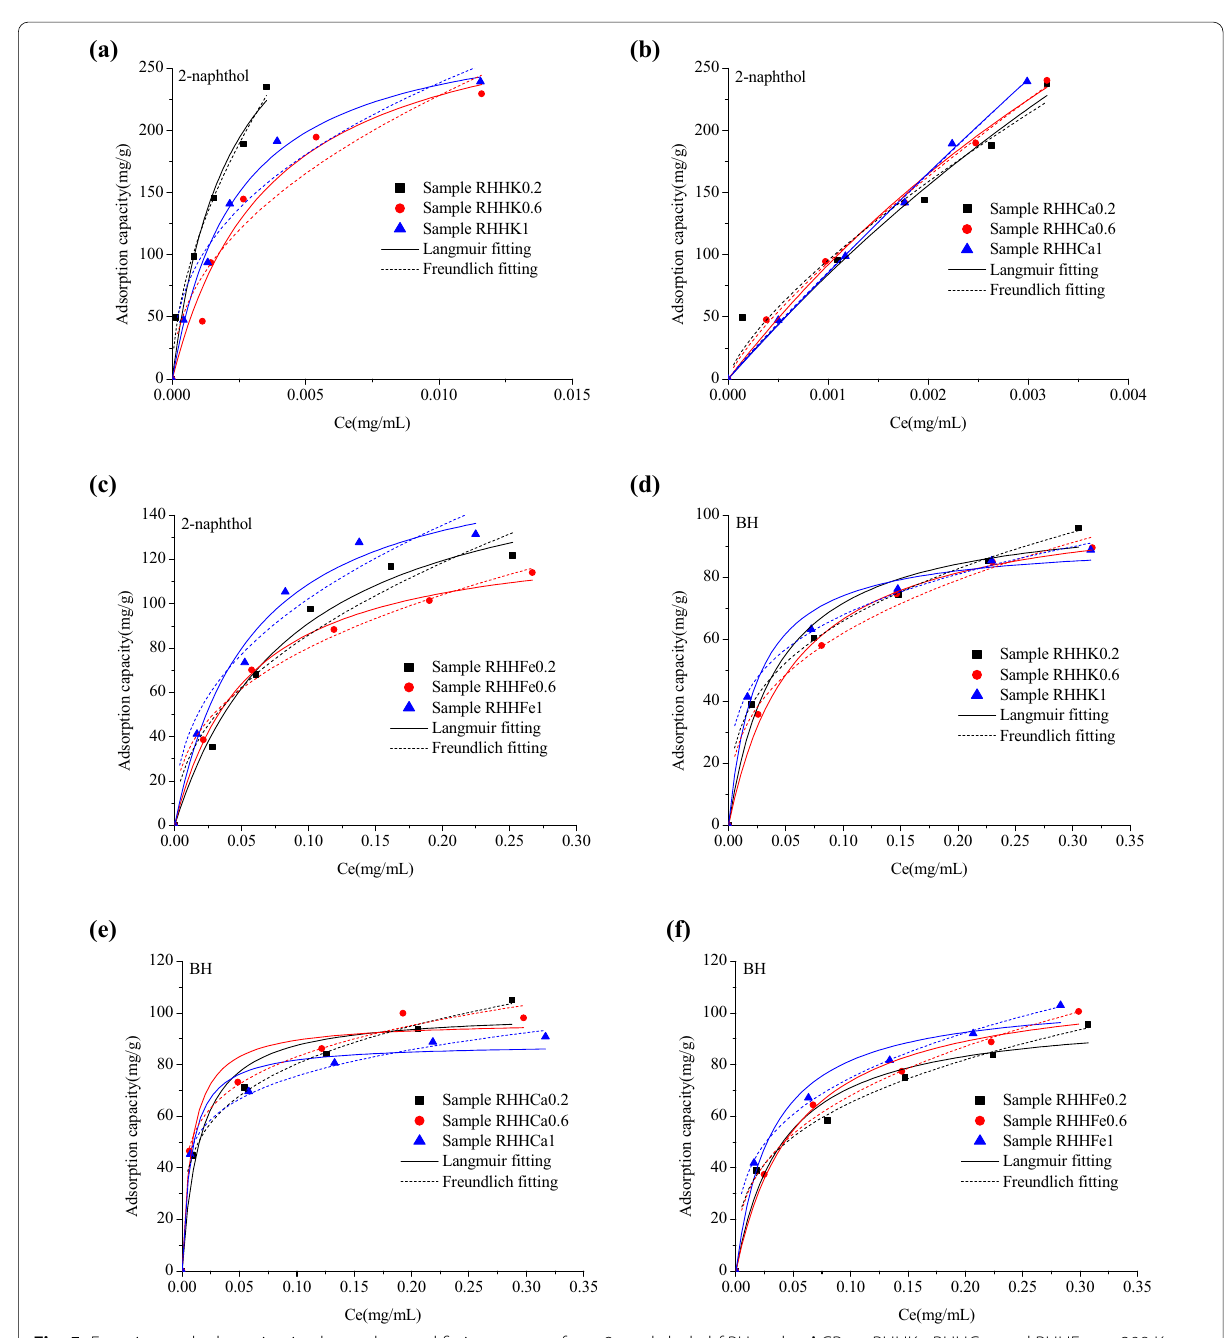
Fig. 5 Experimental adsorption isotherm data and fitting curves of a – c 2-naphthol; d-f BH and g – i CR on RHHKs, RHHCas and RHHFes at 298